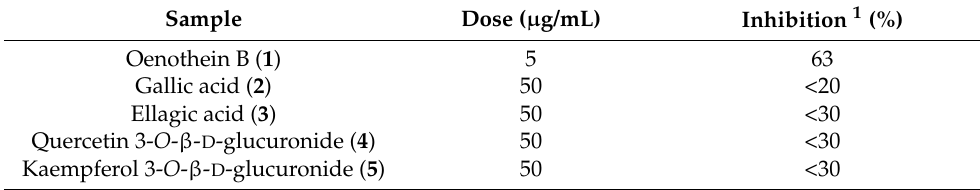
Figure 2. Chemical structures of the major constituents of the ELE. Table 2. Inhibitory effect of constituents of eucalyptus leaf extract on fructose absorption.